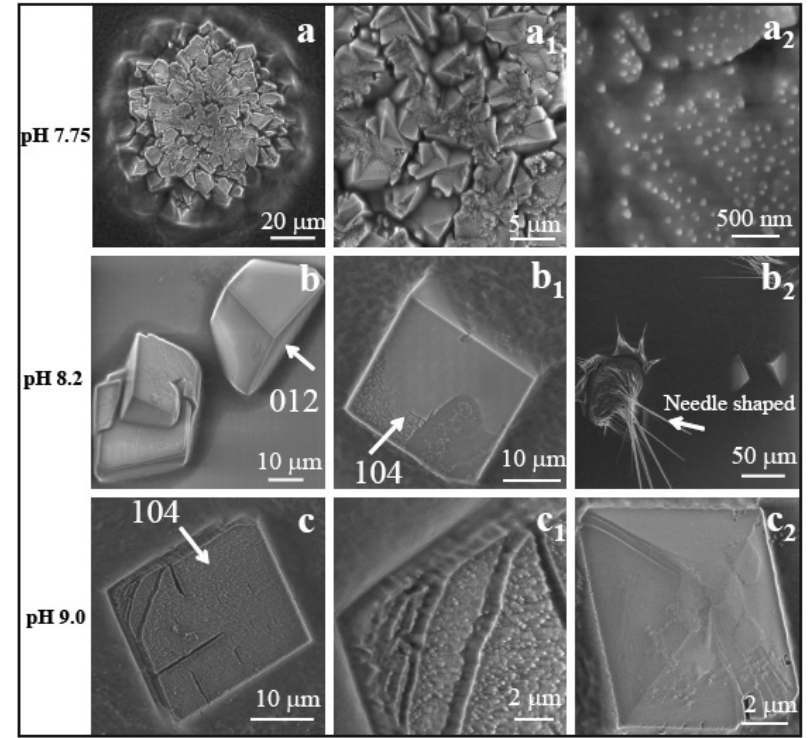
crystal assembly in presence of AS8: ( a ) polycrystalline Figure 5. SEM image of CaCO 3 spherical assembly at pH 7.75; ( b – b ) rhombohedral crystal of calcite in two different 2 orientations: ( b ) (012) and ( b ) (104); ( b ) needle shaped peptide crystals at pH 8.2; 1 2 ) calcite crystal with distorted face and corners observed at pH 9.0. The SEM images ( c , c 1 were taken at 10 keV ( c , c : 5 keV), spot size 3 (1.7 nm; c , c : 2.1 nm). 1 1